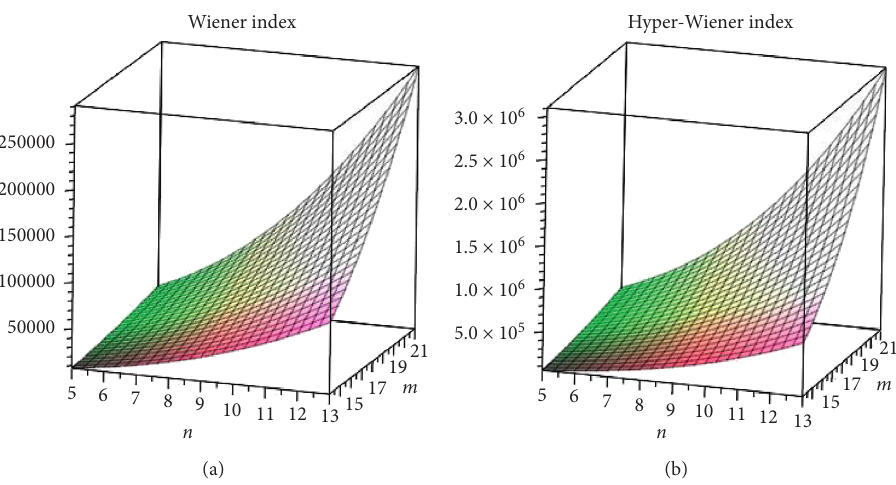
Figure 10: (a) Wiener index and (b) hyper-Wiener index for odd m and n .